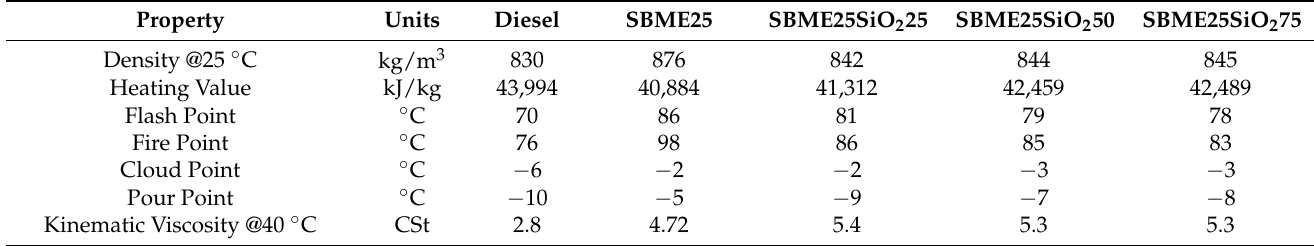
Figure 6. Schematic representation of ultrasound-assisted preparation unit [32]. Table 1. Physicochemical properties of fuel blends.